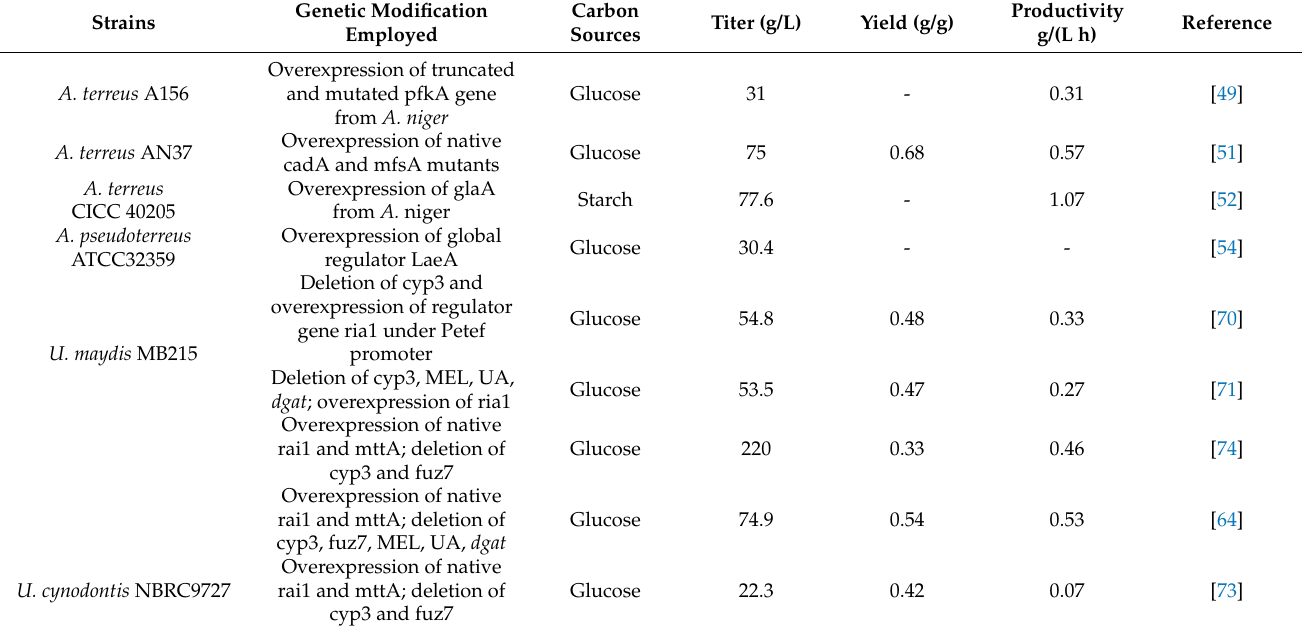
Table 1. Improving ITA production via the genetic modification of natural ITA